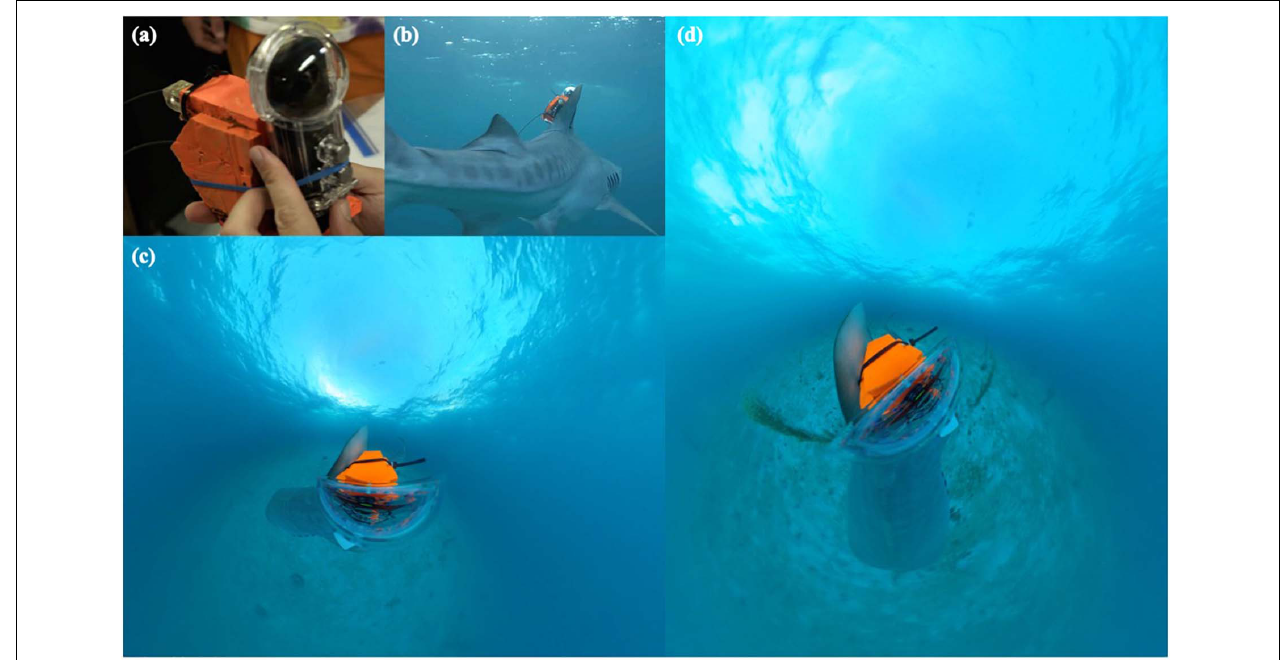
FIGURE 1 | (A) Image of 360-degree camera bio-logger unit and (B) attached to tiger shark in present study; (C,D) video footage from camera highlighting varying perspectives for annotation as the shark moves throughout the water column and over seafloor.